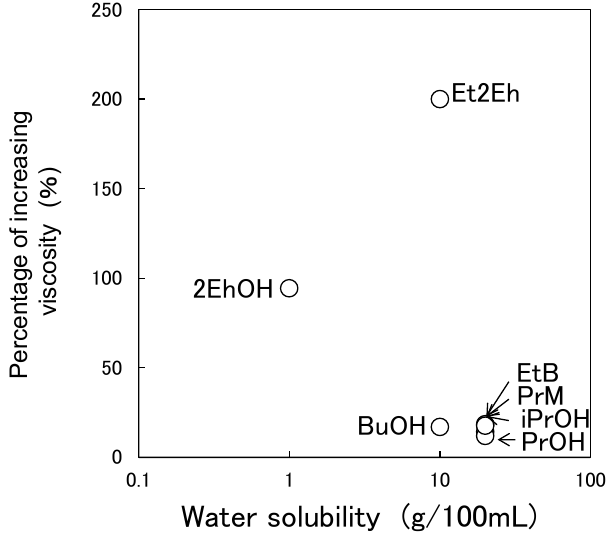
Figure 11. Relationship water solubility at 20 °C and increasing viscosity percentage levels.